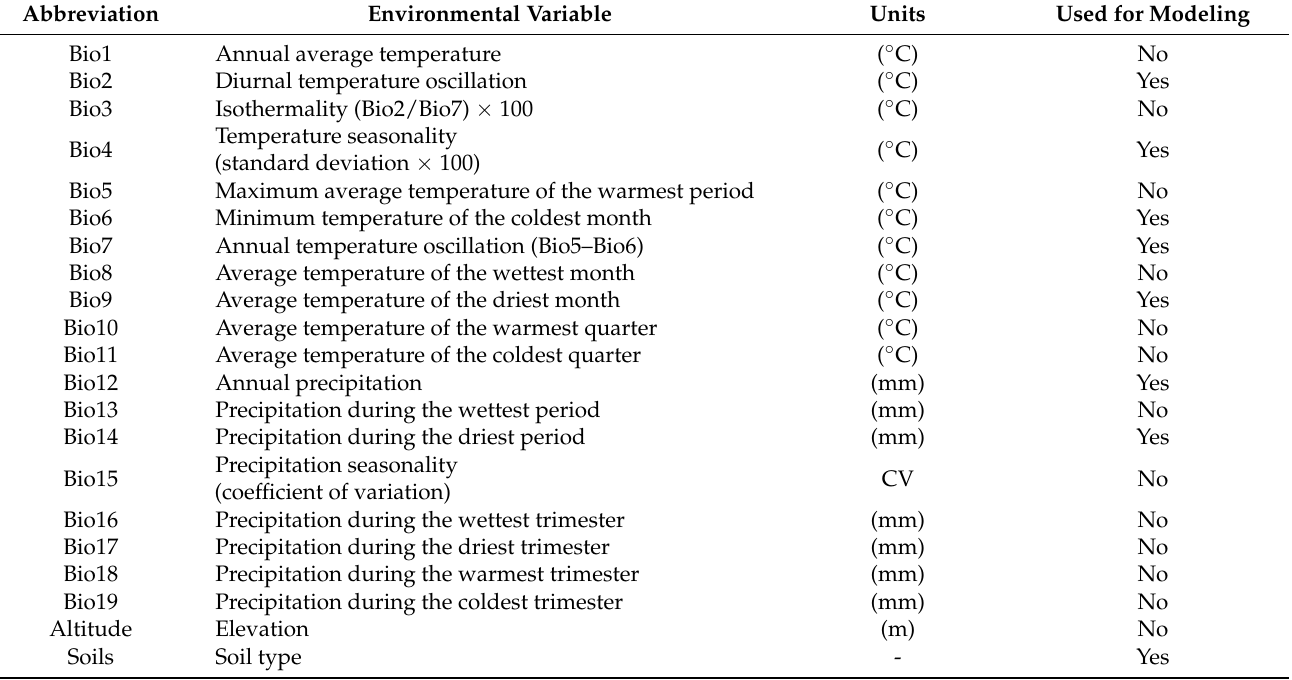
Table 2. Environmental variables used in this